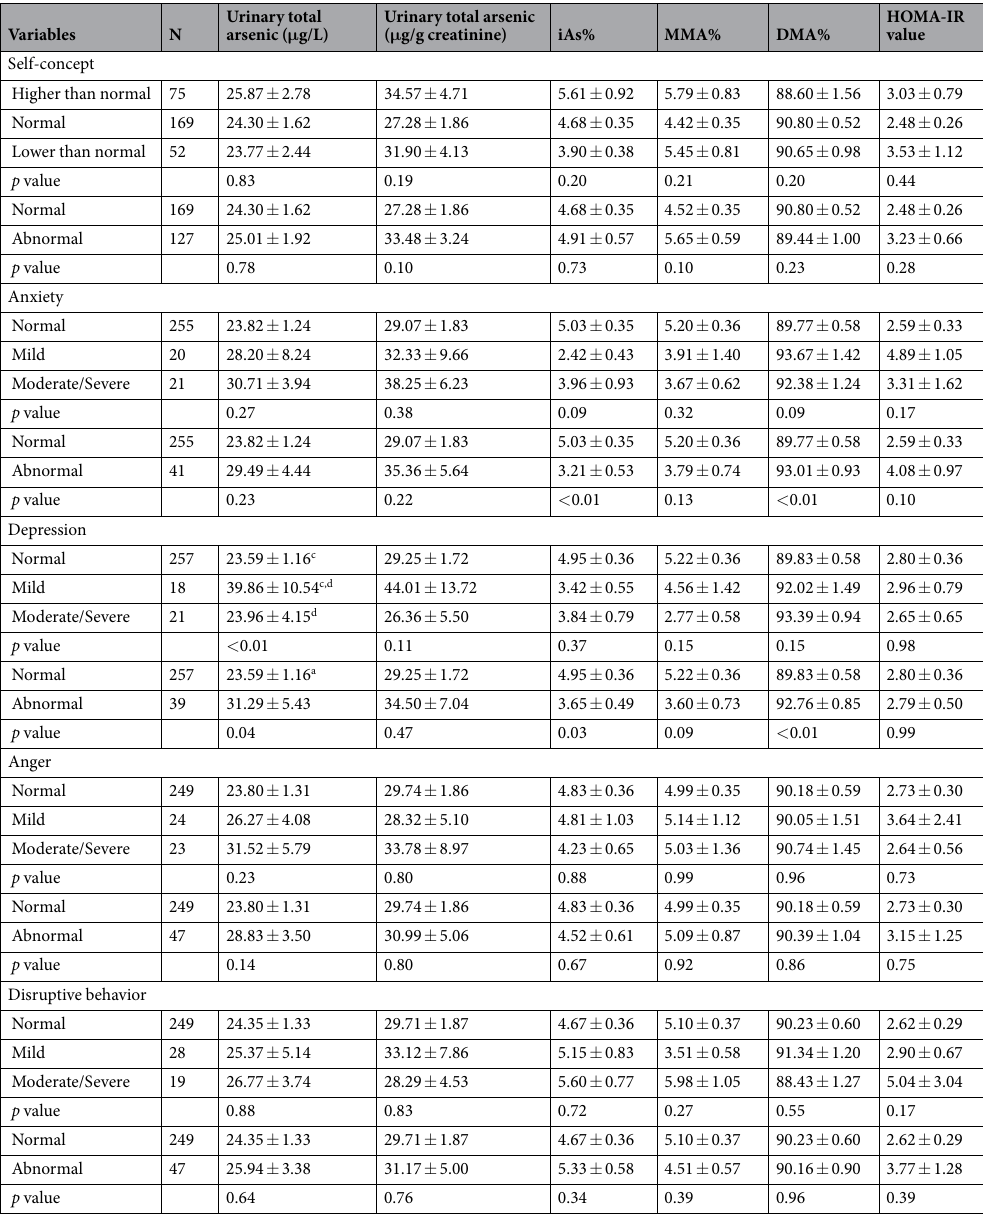
Table 3. Distribution of urinary total arsenic and HOMA-IR values according to psychological characteristics in elementary school students. c Normal depression vs. Mild depression, p < 0.05; d Mild depression vs. Moderate or Severe depression, p <